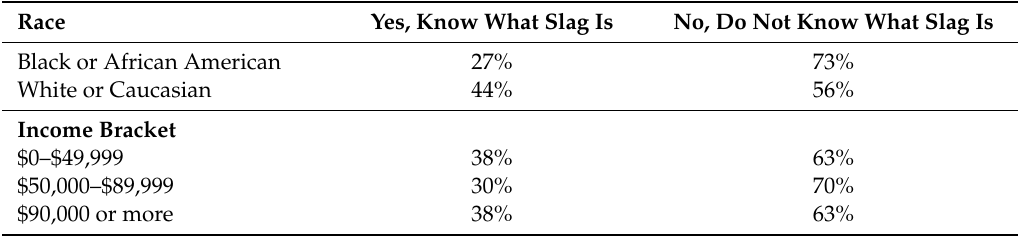
Table4. Theabilityofparticipantstoaccuratelydescribeslagbyrace(top)andbyincomelevels(bottom). Race Yes, Know What Slag Is No, Do Not Know What Slag Is Black or African American 27% 73% White or Caucasian 44% 56% Income